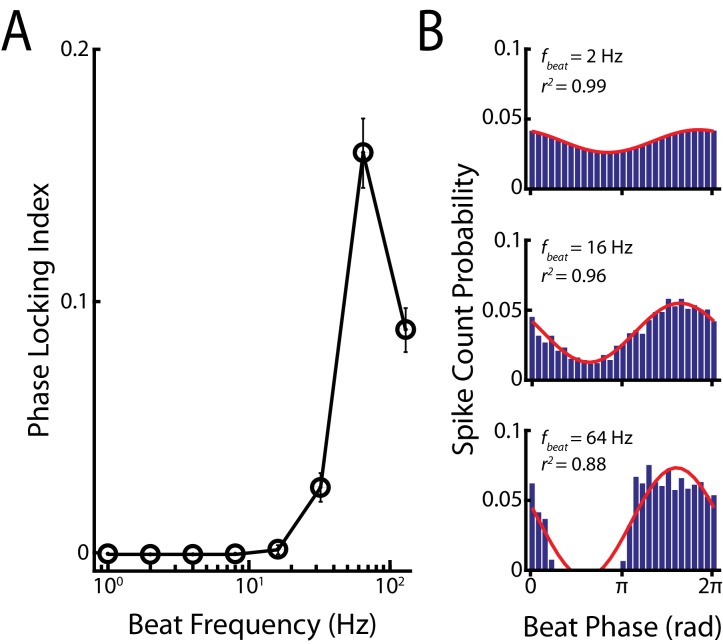
Phase locking in primary afferents to different background beat frequencies.(A) Phase locking index as a function of background beat frequency. (B) Phase histograms of example afferents to background beat frequencies of 2 Hz (top), 16 Hz (middle) and 64 Hz (bottom). Note that complete cessation of firing (i.e. rectification) is only observed in response to the 64 Hz beat frequency.DOI:
http://dx.doi.org/10.7554/eLife.24482.008
10.7554/eLife.24482.009Figure 2—figure supplement 2—source data 1.Source data for Figure 2—figure supplement 2.